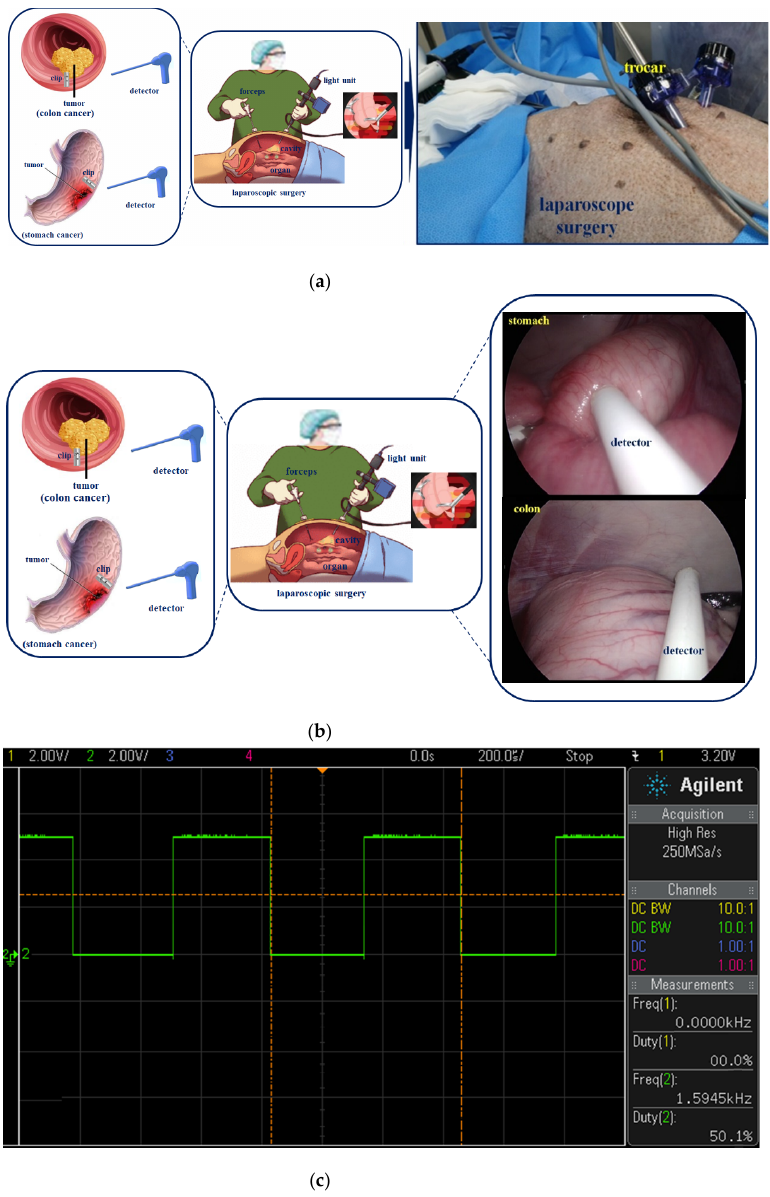
Figure 13. Animal testing of the clip – detector. ( a ) Laparoscope surgery, ( b ) clip detection Video S1, ( c ) clip detection signal. The thickness of the mucosa in the stomach and large intestine between the clip and detector is usually 2 and 1 cm, respectively. The detector is separated by a distance of 0.5